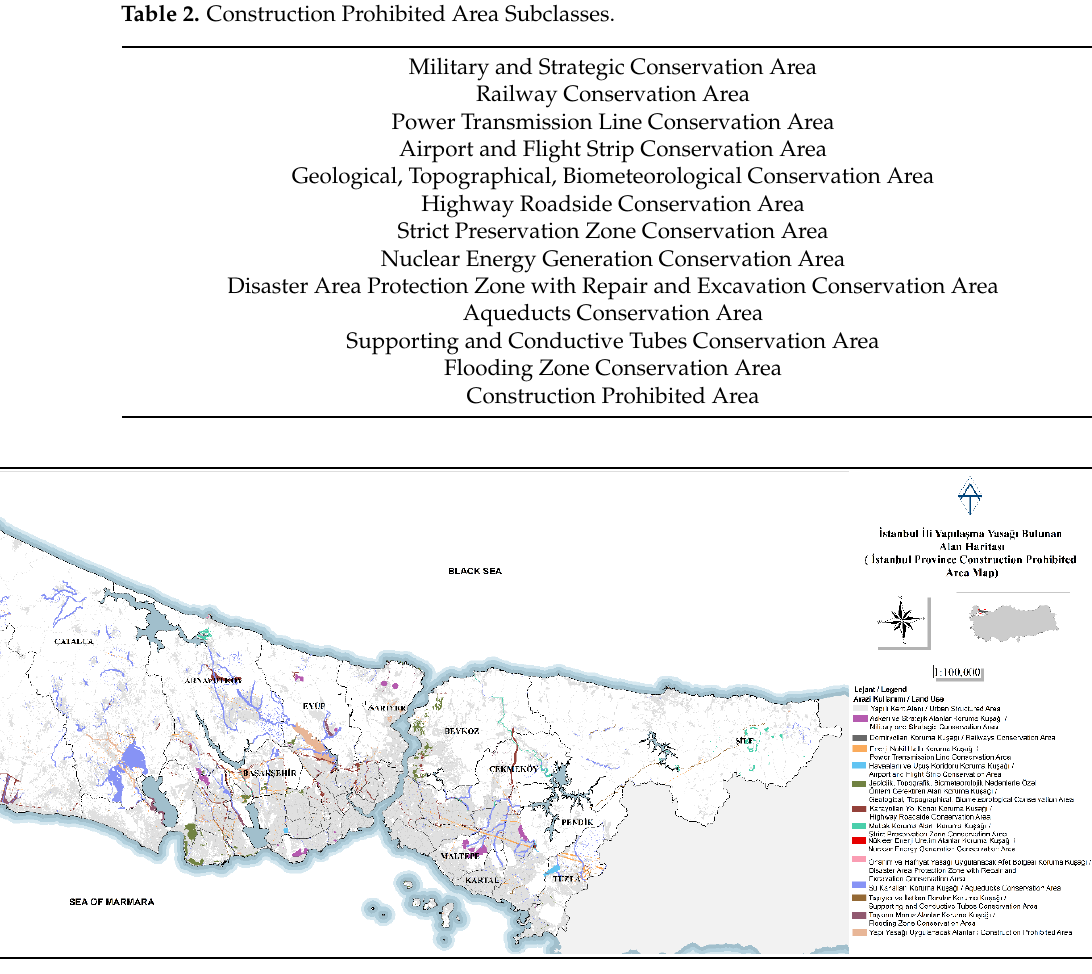
Figure 14. Istanbul Province Construction Prohibited Area Map.